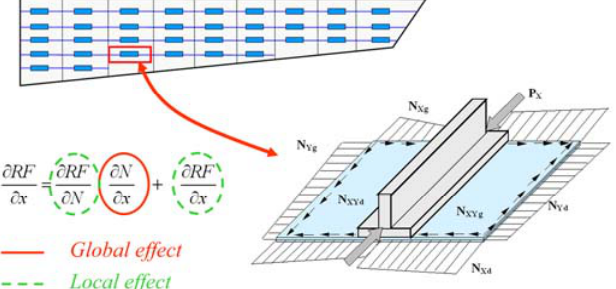
Fig. 3. The bottom surface of a wing and its associated su- per-stiffeners where local computations are carried out